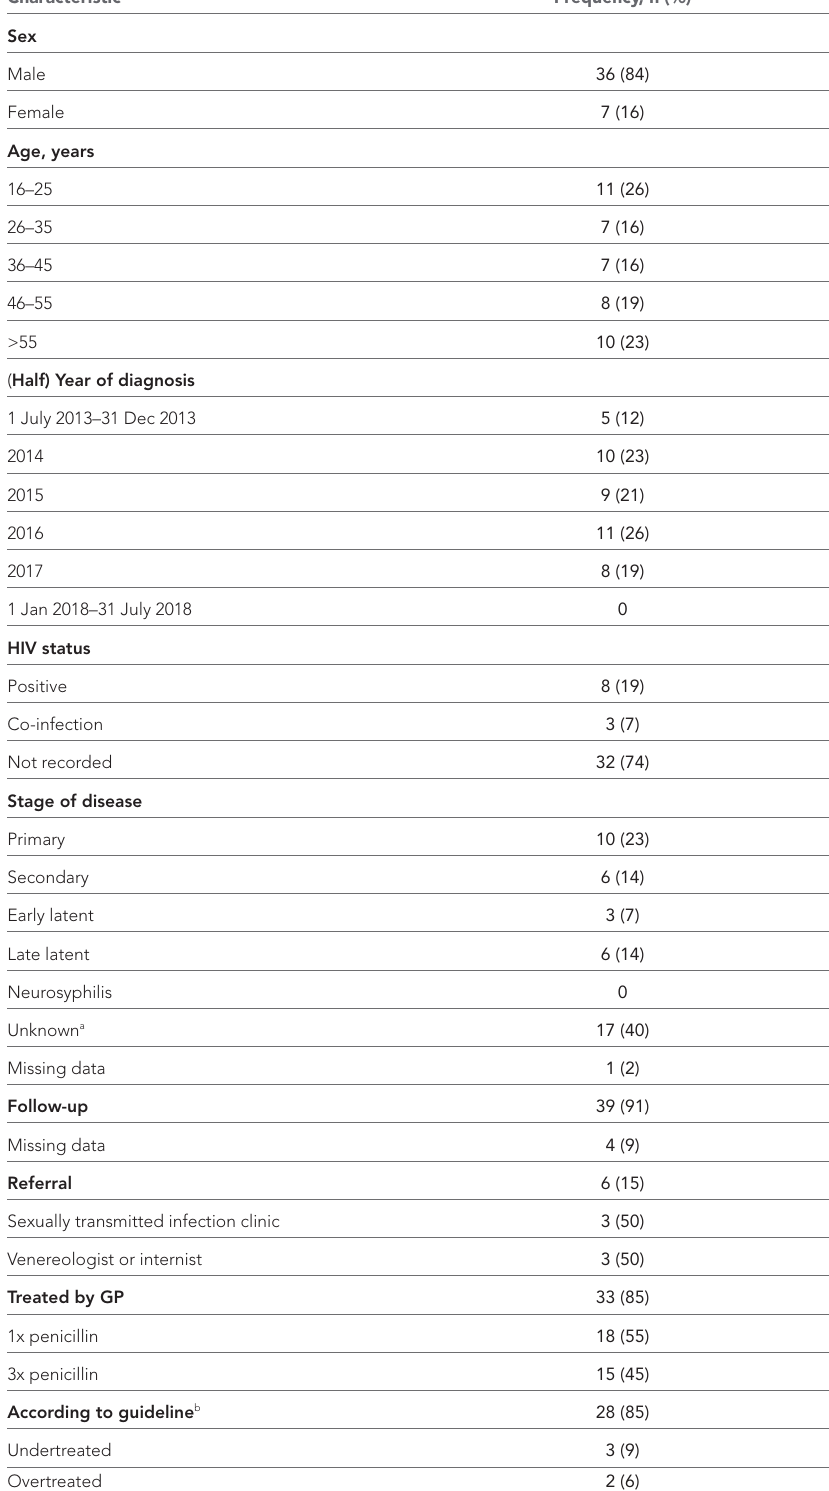
Table 2 Characteristics of syphilis cases in general practice ( n = 43)